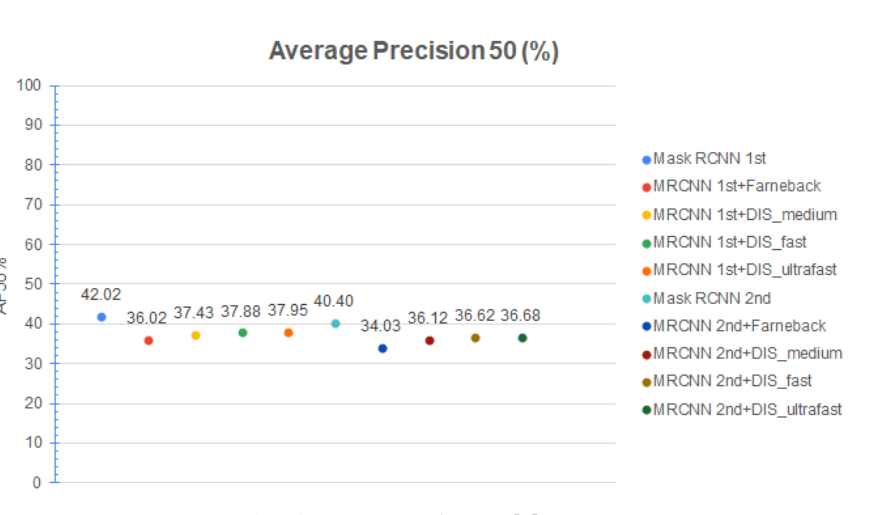
Figure 8. Average Precision (50%), Cityscapes dataset [2].